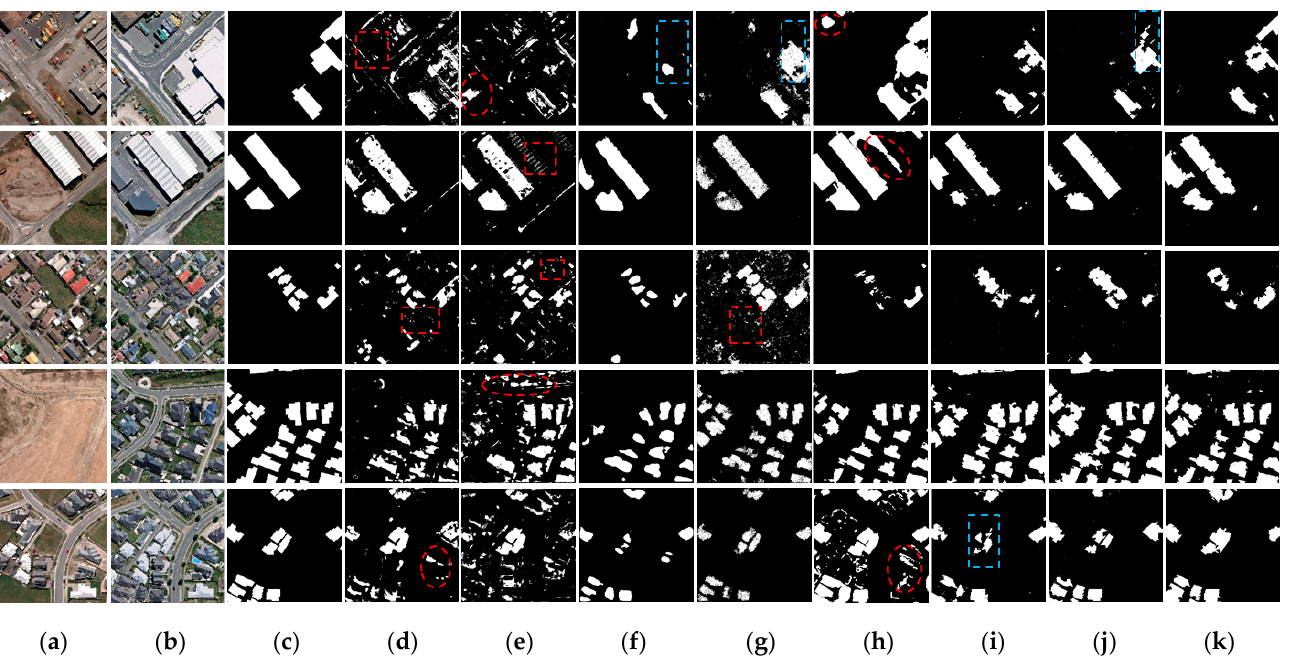
Figure 11. Some typical CD maps by different methods on the WHU-CD data set. ( a ) Image T1. ( b ) Images T2. ( c ) Reference change map. ( d ) FC-Siam-con. ( e ) FC-Siam-diff. ( f ) Siam-NestedUNet. ( g )